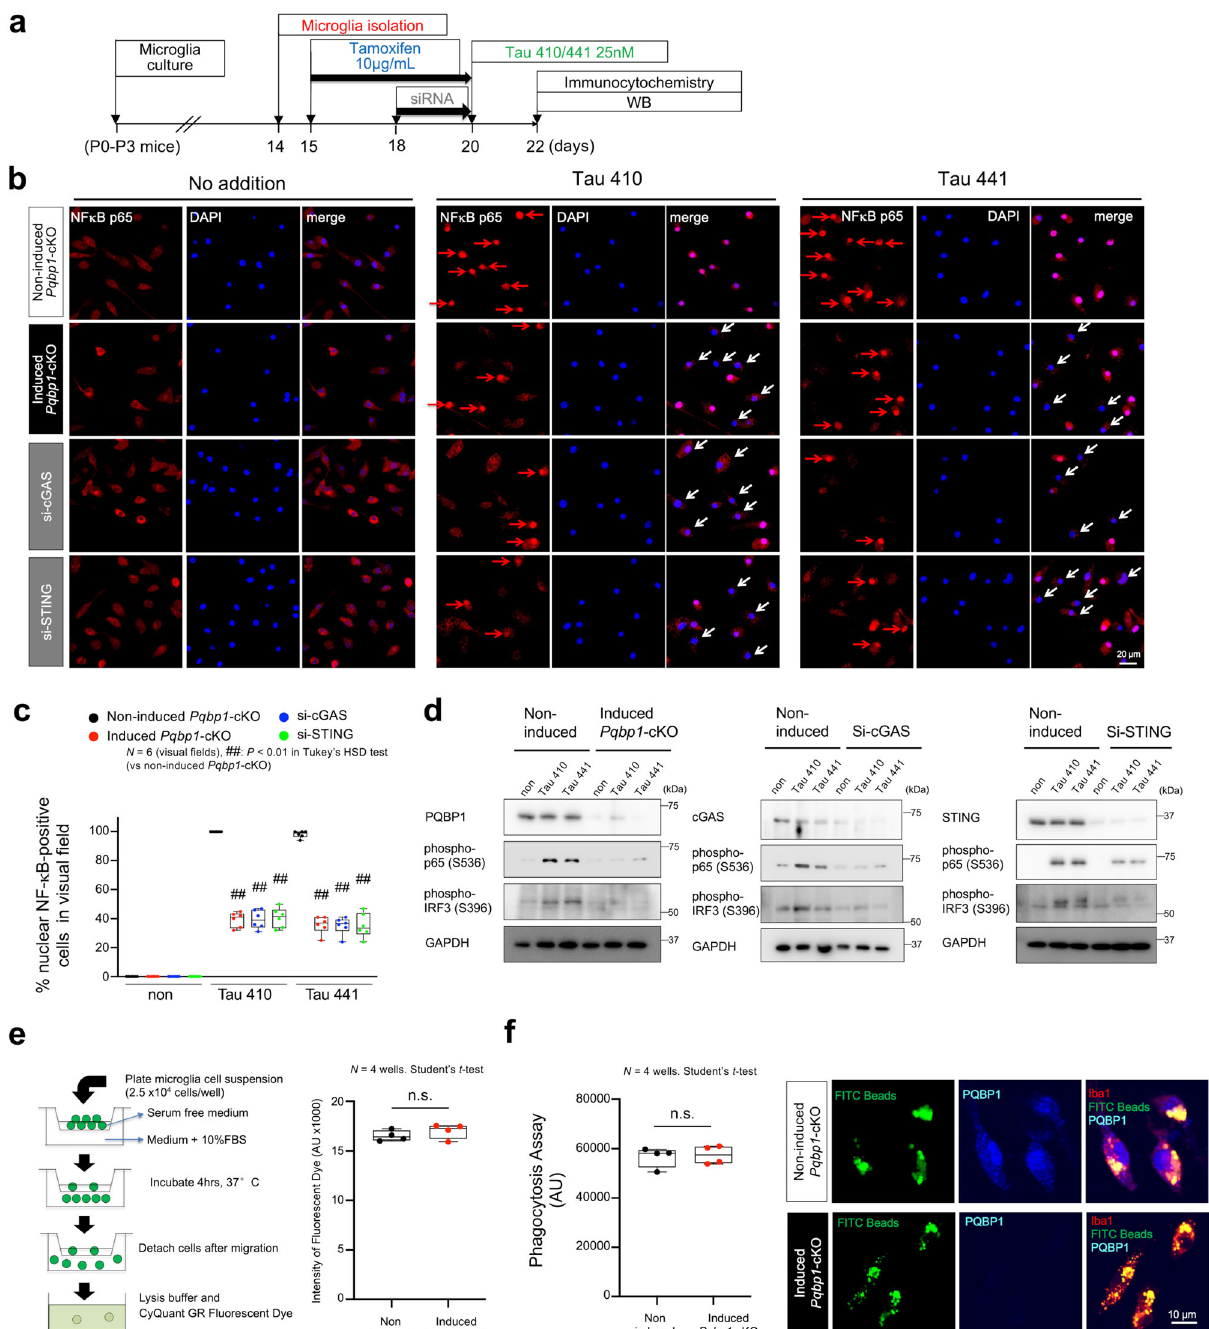
Fig. 4 PQBP1 – cGAS – STING pathway mediates Tau-induced NF κ B activation in microglia. a Protocol of tamoxifen-induced Pqbp1 knockout in